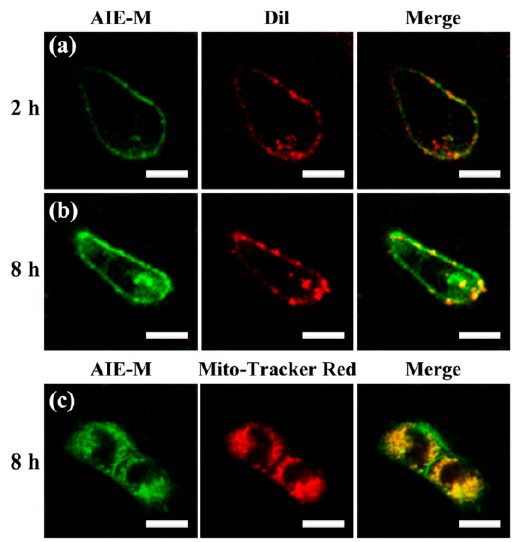
Figure 6. CLSM images of HeLa cells separately incubated with AIE-M (20 μ M) for 2 h ( a ) or 8 h ( b , c ). HeLa cells were separately co-stained with 10 μ M Dil ( a , b ) or 200 nM Mito-tracker Red ( c ). The scale bar is 20 μ m.